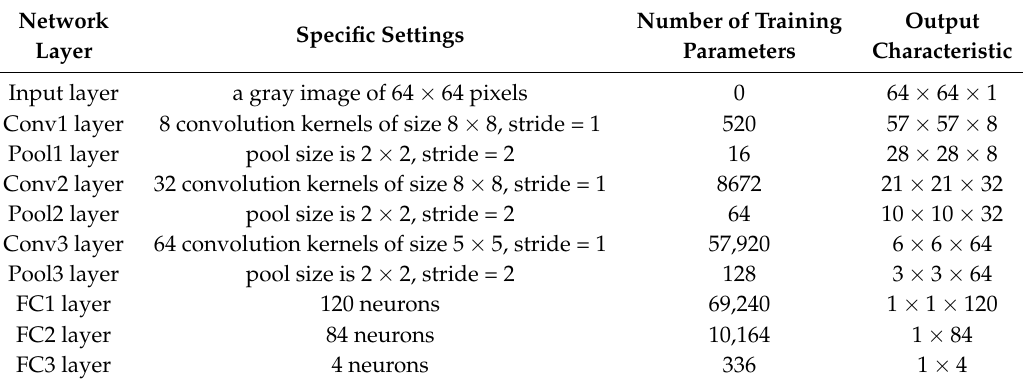
Table 3. Detailed settings of improved 2D LeNet-5 network